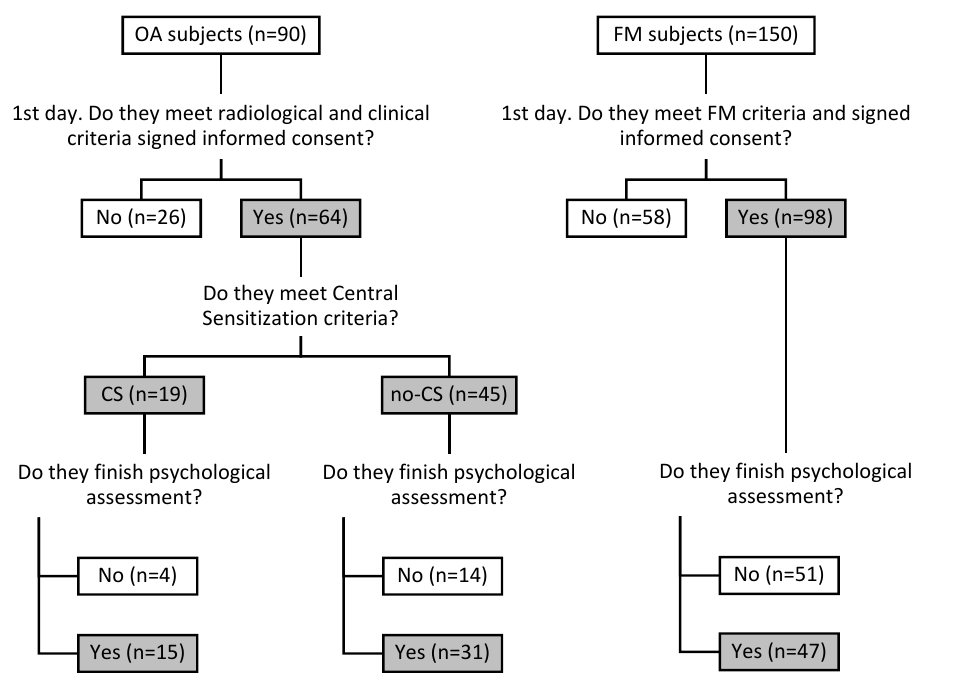
Figure 1. Flow chart of the selection sample process. Note: OA: osteoarthritis, FM: fibromyalgia, OA-CS: osteoarthritis with central sensitization, OA-noCS: osteoarthritis without central sensitization.